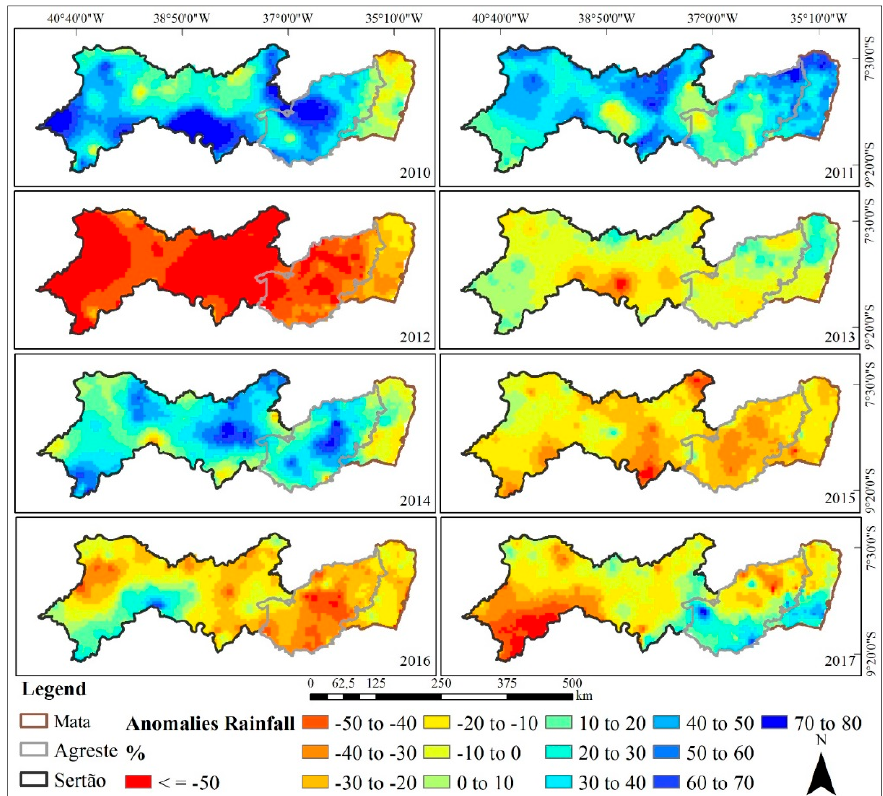
Figure 11. Precipitation annual anomaly of each year in relation to the entire period of 2010 to 2017. Precipitation data source: Center for Weather Forecasts and Climate Studies of the National Institute for Space Research